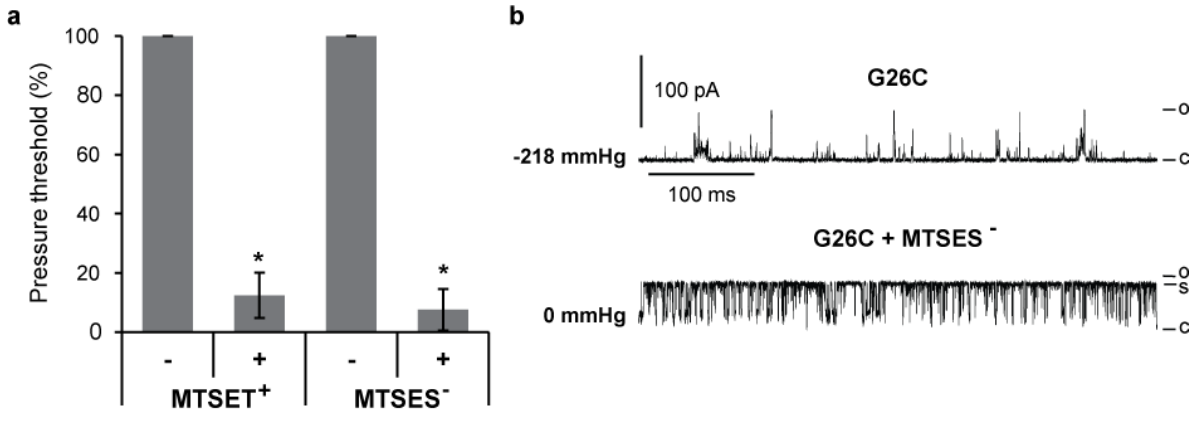
Figure 3. Effects of charged MTS modifications on G26C MscL gating. ( a ) The graph shows the changes in the pressure required to gate G26C MscL before and after treatment with charged MTS reagents MTSET + and MTSES − (n ≥ 3). Values were normalized to the pressure required to gate the channel before treatment. ( b ) The current traces of a typical patch clamp experiment in native membranes from giant spheroplasts are shown before ( top ) and after ( bottom ) the addition of MTSES − to the patch chamber buffer. The pressures at which the traces were recorded are indicated at the left in mmHg. The letters C, S and O on the right of the traces indicate closed, sub-conductive and open states respectively ( * p ≤ 0.004 in Student t-test paired control vs .